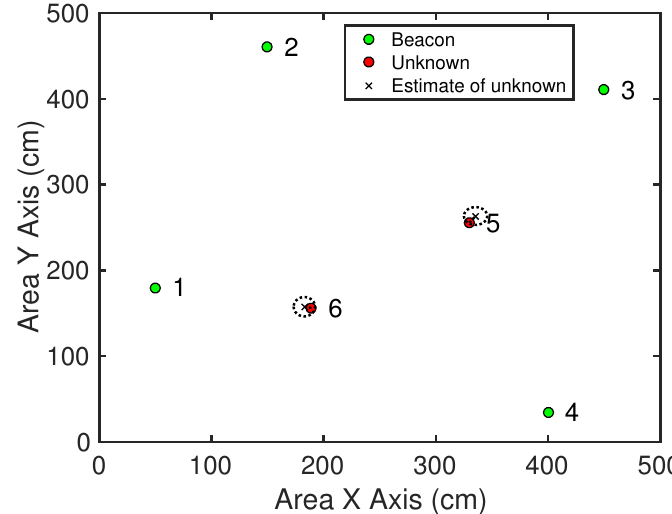
Figure 20. The position estimate and the estimated uncertainty on each unknown node at the end of the experiment for one random generated topology when using KK-imp algorithm under acoustic measurements. The ground-truth position of the unknowns are represented by red dots, and current position estimates are represented by black crosses. The estimated uncertainty of each unknown is represented by an ellipse (circles when using KI), and the semi-axes of the ellipse are 3 σ of the estimated uncertainty distribution (modeled as Gaussian), in x and y